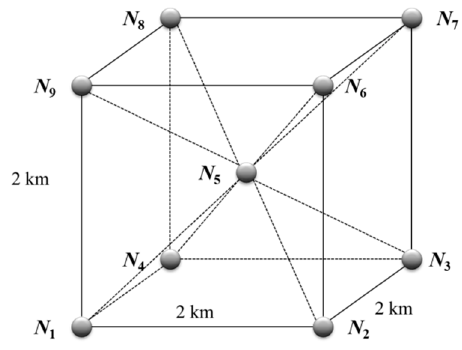
Figure 7. The ideal underwater sensor network.